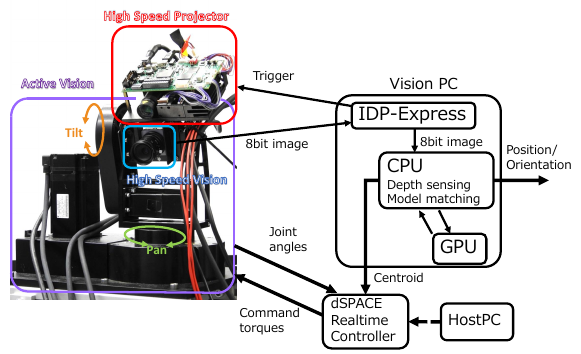
Figure 2. System configuration.